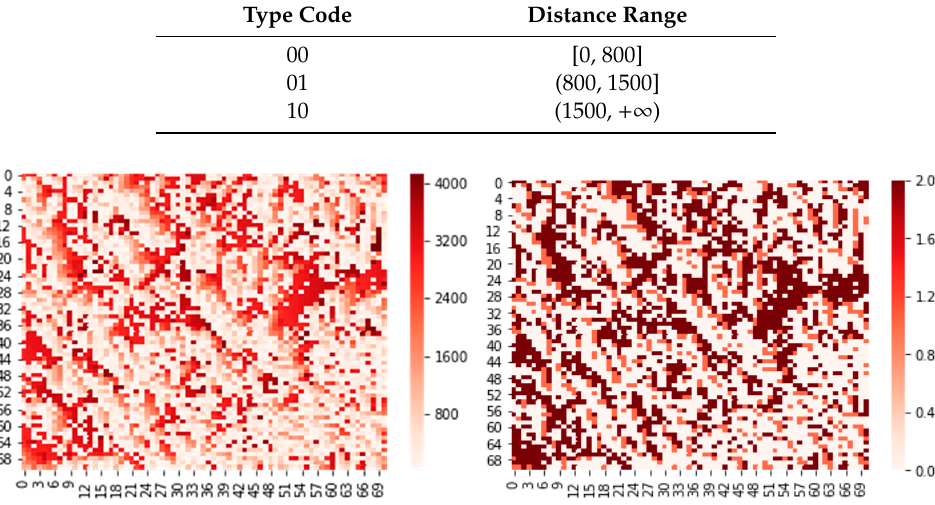
Figure 20. Heatmap ( left ) and distance classification map ( right ).